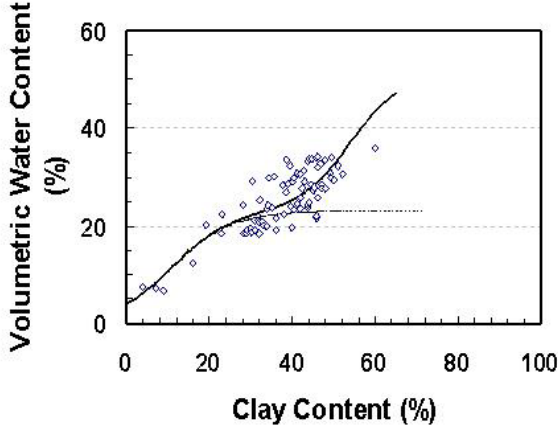
FIGURE 2. An example of the fit of a single-stage (dashed line) and a two-stage (solid line) GEMLS to data published by Olson[26]. Data are for –1500 kPa determinations on silt loam soils in eastern South